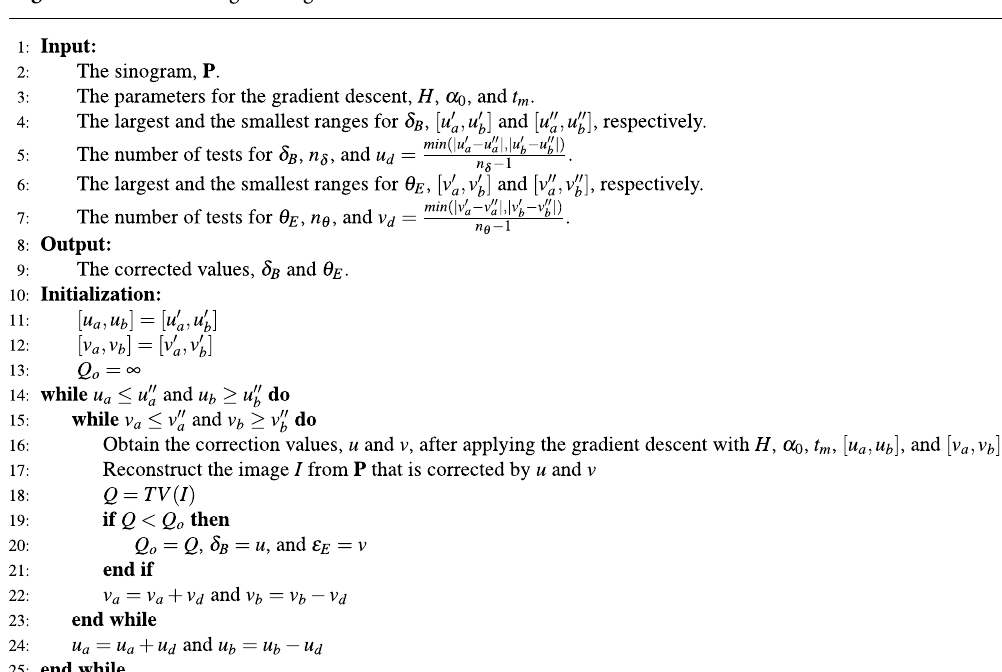
Algorithm 1. Multi-range